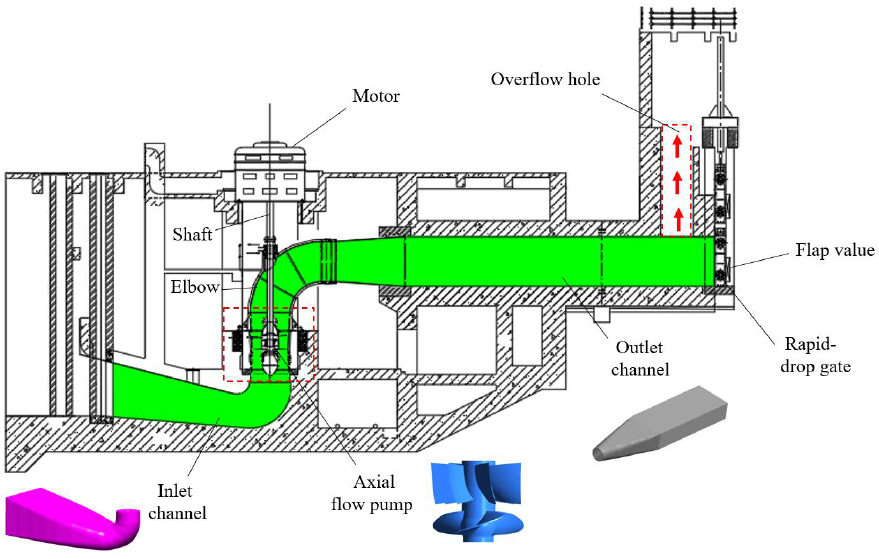
Figure 1. Schematic diagram of LAPS.